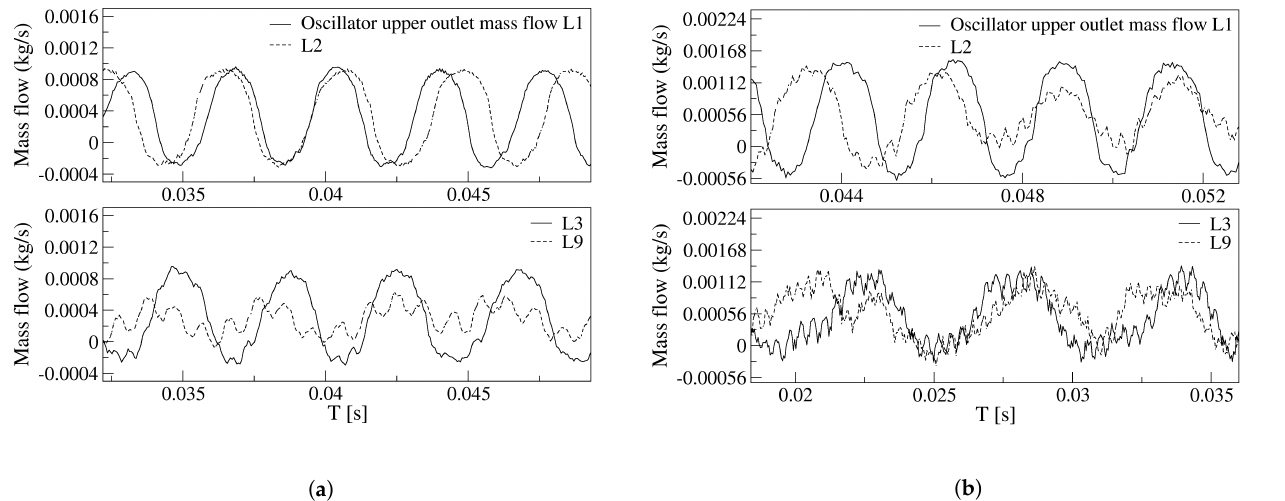
Figure 9. Fluidic oscillator upper outlet mass flow as a function of the different feedback channels length. ( a ) Power nozzle velocity, 65 m/s. ( b ) Power nozzle velocity, 97